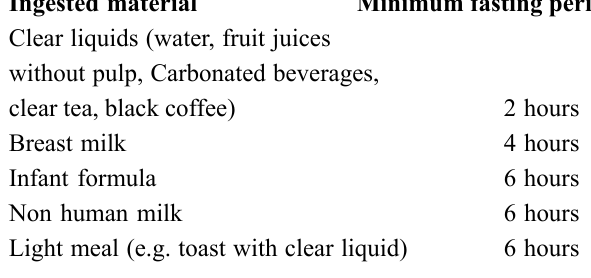
Table I : Number of children and complications according to age